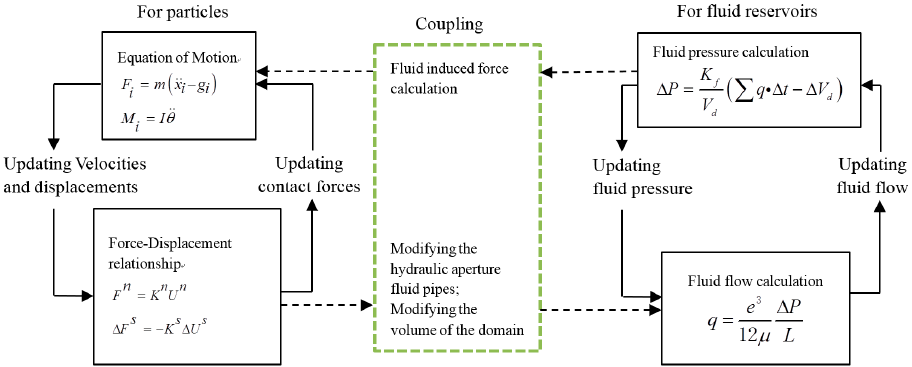
Figure 3. Modeling procedures for a fluid ‐ mechanical coupling.